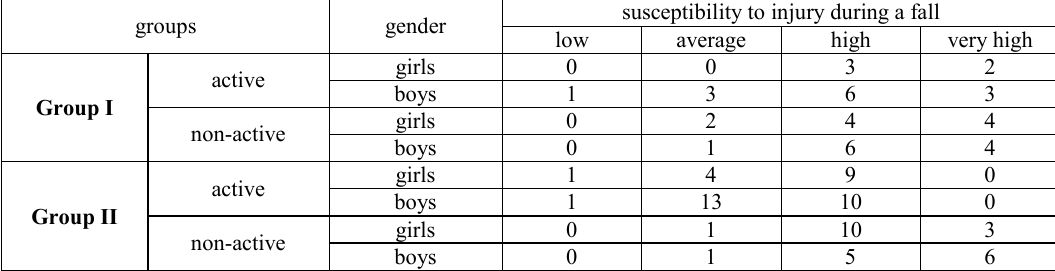
Level of susceptibility to injury during a fall of girls and